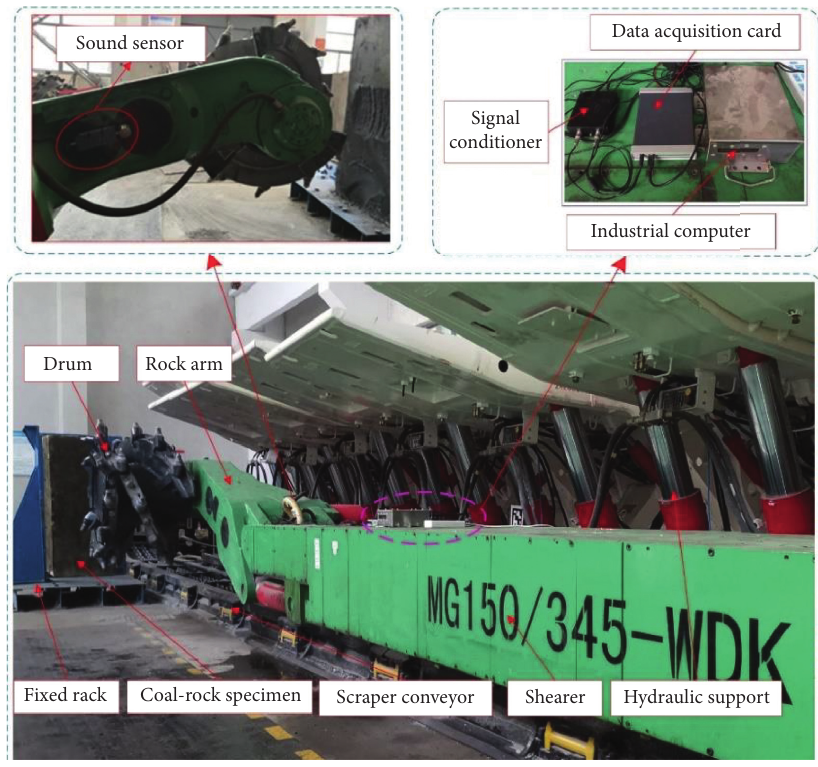
Figure 9: The experiment system of shearer cutting coal-rock.